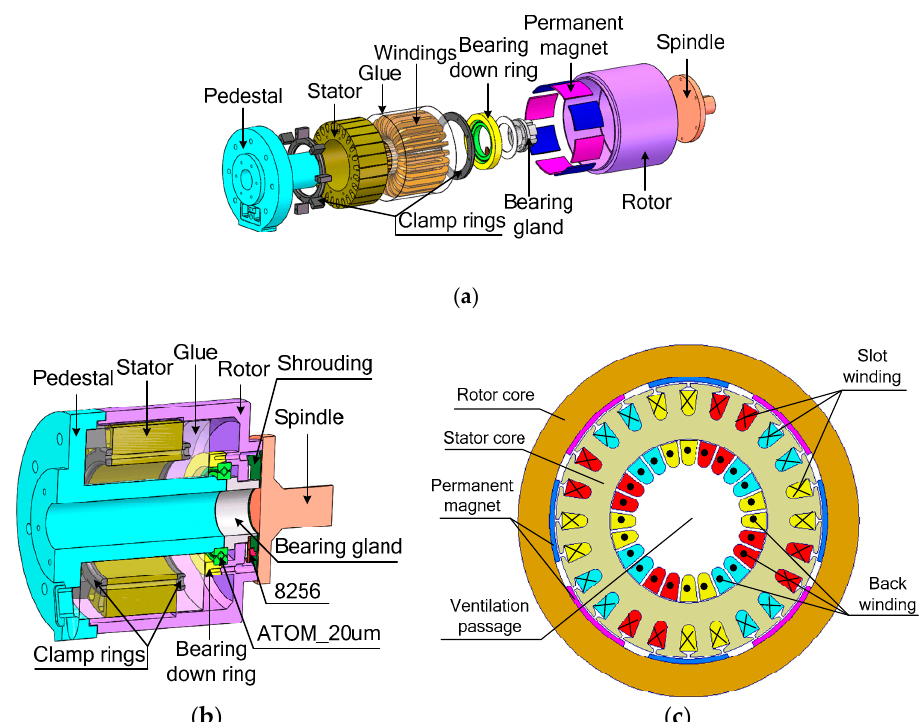
Figure 1. The diagrammatic sketches of the N-TWDDPMSM: ( a ) exploded view of mechanical structure of N-TWDDPMSM prototype; ( b ) section view of mechanical structure of N-TWDDPMSM prototype; ( c ) assumption diagram of simulation structure of N-TWDDPMSM.